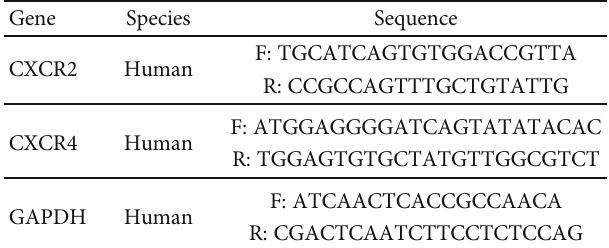
Table 2: Primers used for